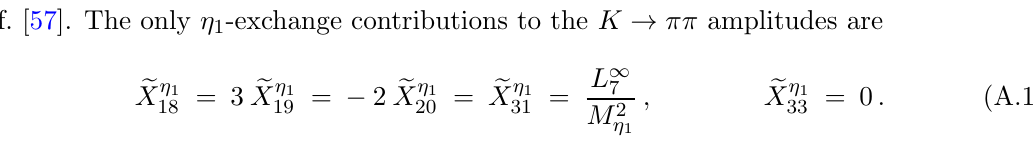
of the ( g 8 Z i ) 1 LECs in eq. i